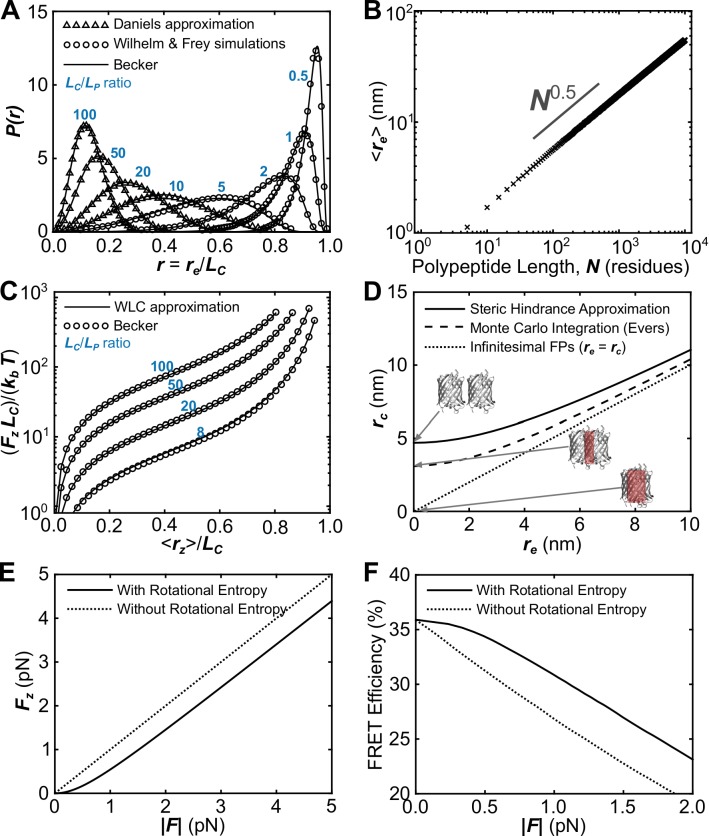
Verification of the proper implementation of a biophysical model describing the mechanical sensitivity of FRET-based TSMods.(A) Probability distributions of polypeptide end-to-end distance (re), normalized to contour length (LC) such that r=re/LC calculated using the second Daniels approximation (Daniels, 1952; Yamakawa and Stockmayer, 1972), simulations from (Wilhelm and Frey, 1996), and an ansatz approximation used in the proposed model based on (Becker et al., 2010) that smoothly bridges between various mechanical regimes. (B) Demonstration that the numerical ansatz predicts the standard length re~N1/2 scaling behavior characteristic of unstructured polypeptides. (C) Under load, the average extension (rz) of the polypeptide extensible domain predicted by the (Becker et al., 2010) ansatz closely follows the previous prediction of the force-extension curve for a worm-like chain (Bouchiat et al., 1999). (D) Possible approaches to estimate the chromophore separation distance (rc), from polypeptide end-to-end distance (re). Note that some approaches predict unphysical overlap of the FPs at short linker lengths, which is highlighted in red for the extreme condition of infinitesimal linker length. (E, F) The proposed model includes a dimensionless group (determined by the applied load, the rest length of the construct, and thermal energy) that heuristically accounts for the effects of rotational entropy. This results in a reduced amount of force transferred through FPs to the polypeptide at low applied force (E); this difference between the force causing extension of the polypeptide (Fz) and applied force (F) manifests in a plateau in the FRET-force relationship at very small loads (F).10.7554/eLife.33927.014Figure 2—figure supplement 2—source data 1.Numerical simulations of the mechanical behavior of worm-like chains.